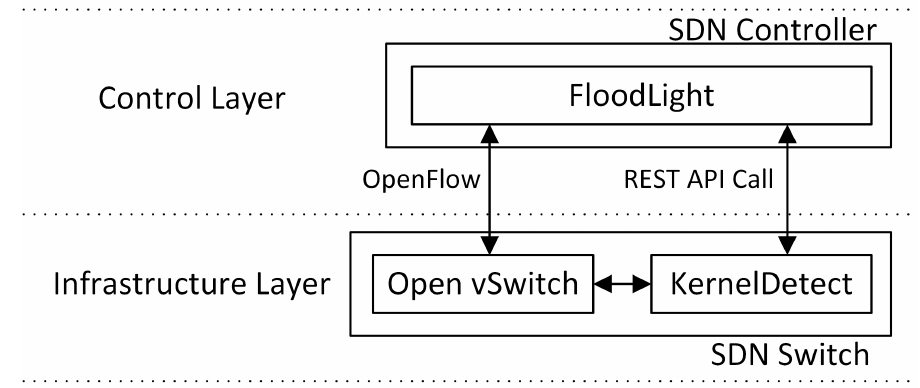
Figure 1. The placement and functionality of KernelDetect for network traffic flows.